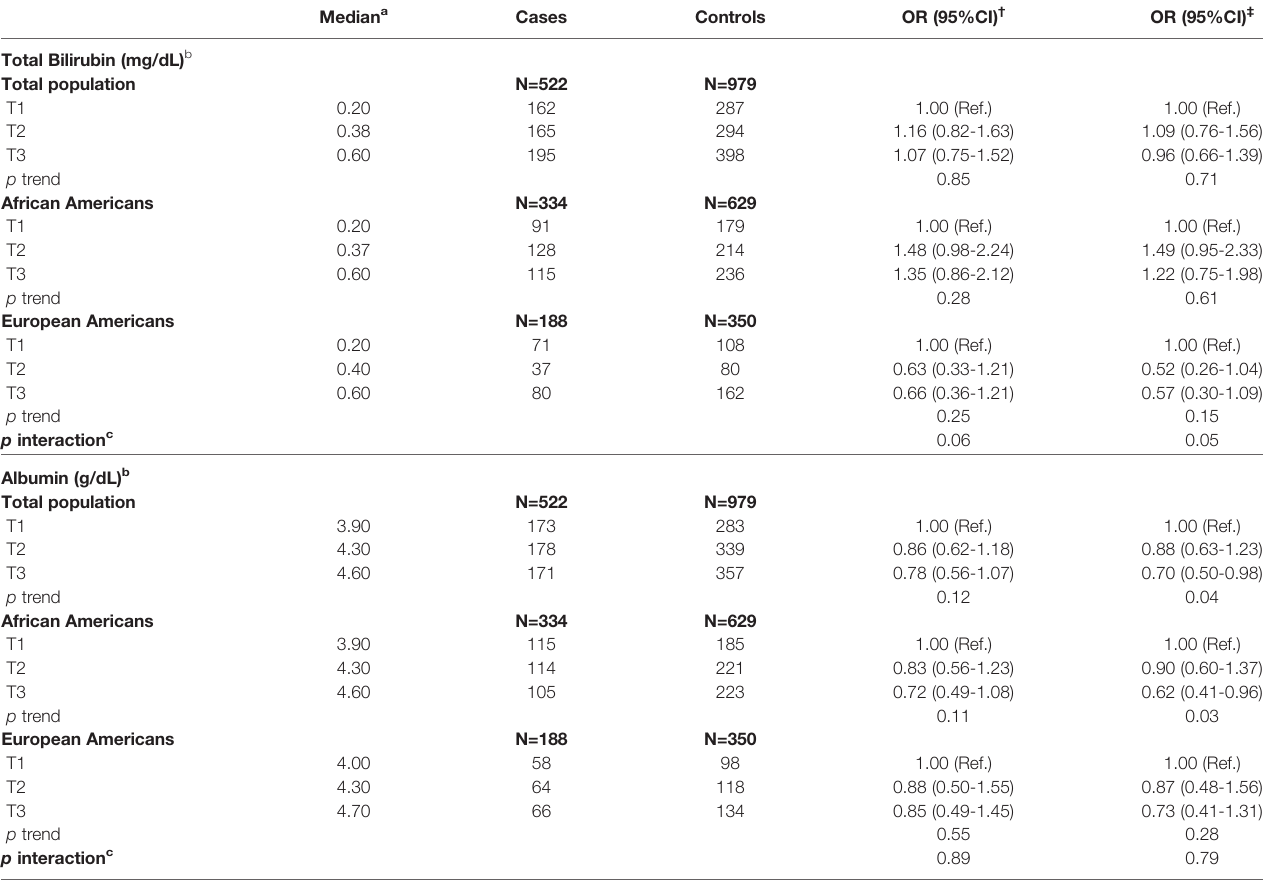
TABLE 2 | Association of serum levels of total bilirubin and albumin with lung cancer risk. Median a